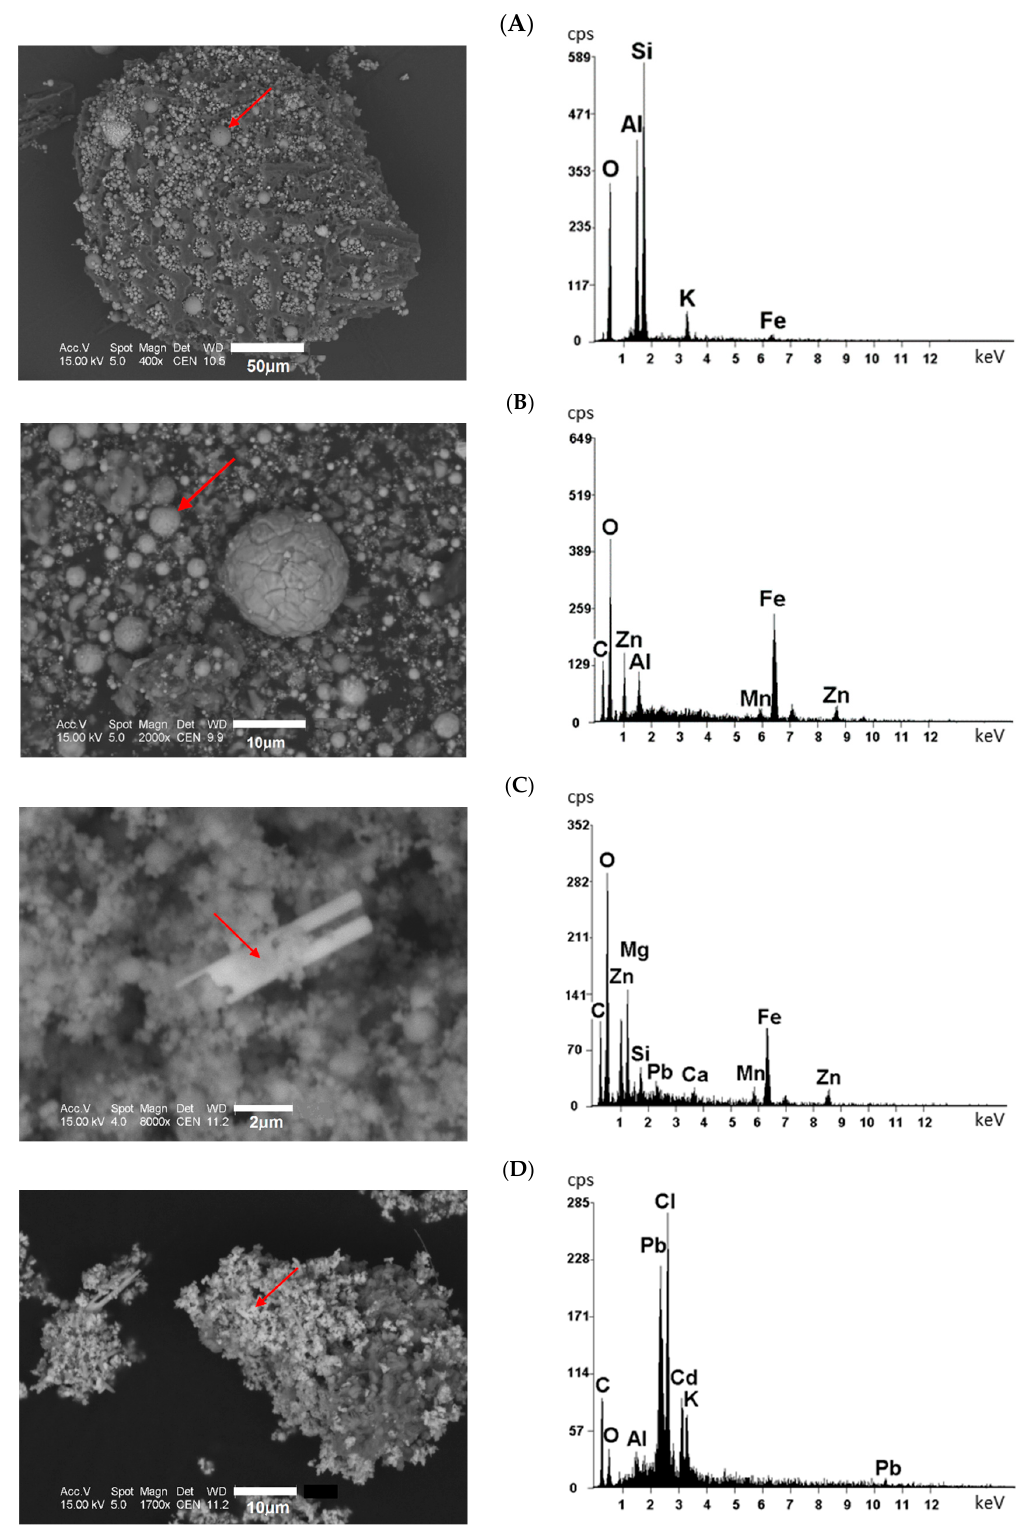
Figure 6. SEM images and related EDS spectra of fly ashes from power plants ( A ), steel metallurgical dusts ( B ), metallurgical dust from dedusting ( C ), dusts after Pb, Zn ore smelting ( D ); red arrows show the points where presented EDS spectra have been performed (axes description: cps—counting per second; energy—keV).